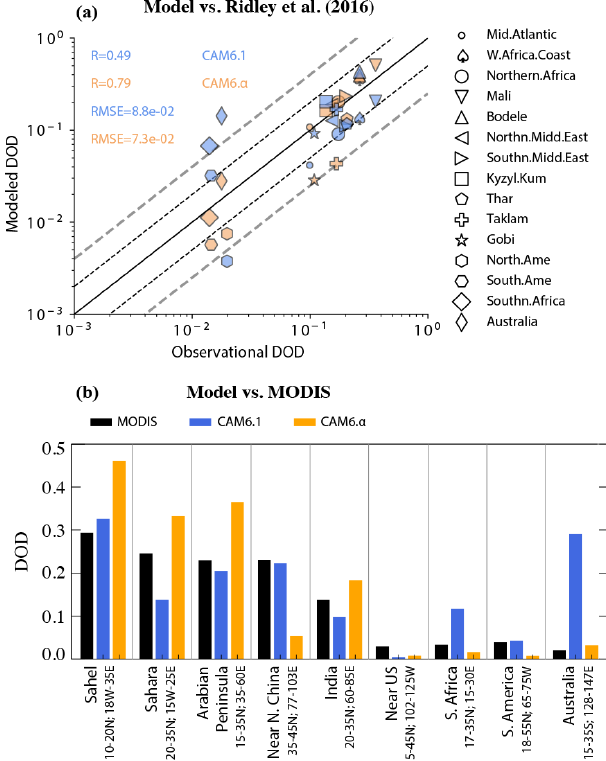
Figure 3. Modeled DOD in CAM6.1 (blue) and CAM6. α (orange) in comparison with that from Ridley et al. (2016) at sub regions as defined in their Fig. 1 and from MODIS retrievals (b) at sub regions (see x axis labels). Both correlations, shown as the Kendall’s τ in panel (a) , are statistically significant at the 95% confidence level. Black and gray dashed lines in panel (a) represent a factor of 2 and 4 differences.